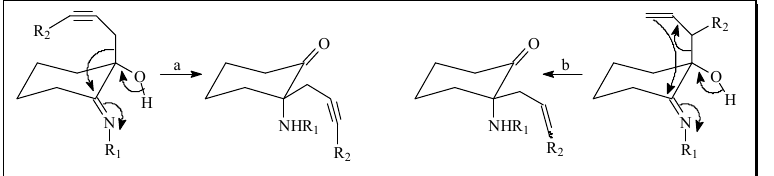
Figure 3. Exo rearrangement in six member ring systems according to Compain